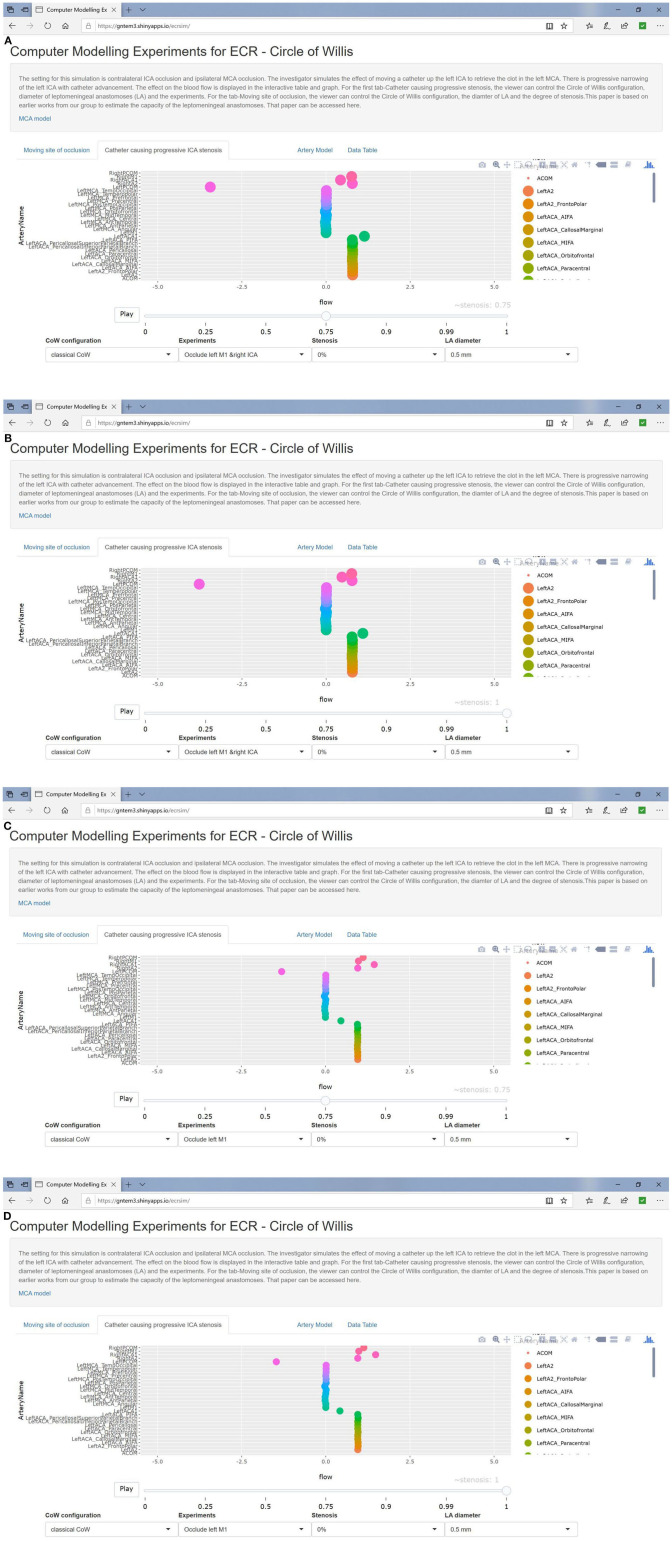
(A,B) Simulated catheter movement reduced flow to 86% of baseline in left ACA branches in setting of contralateral ICA occlusion. In (C,D), catheter movement has no effect even at 100% stenosis (absence of contralateral ICA occlusion).